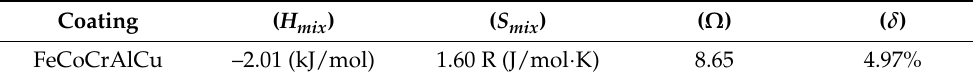
Table 4. Solid-solution formation parameters for the FeCoCrAlCu HEA coating. Coating ( H mix ) ( S mix ) ( Ω ) ( δ ) FeCoCrAlCu –2.01 (kJ/mol) 1.60 R (J/mol ·